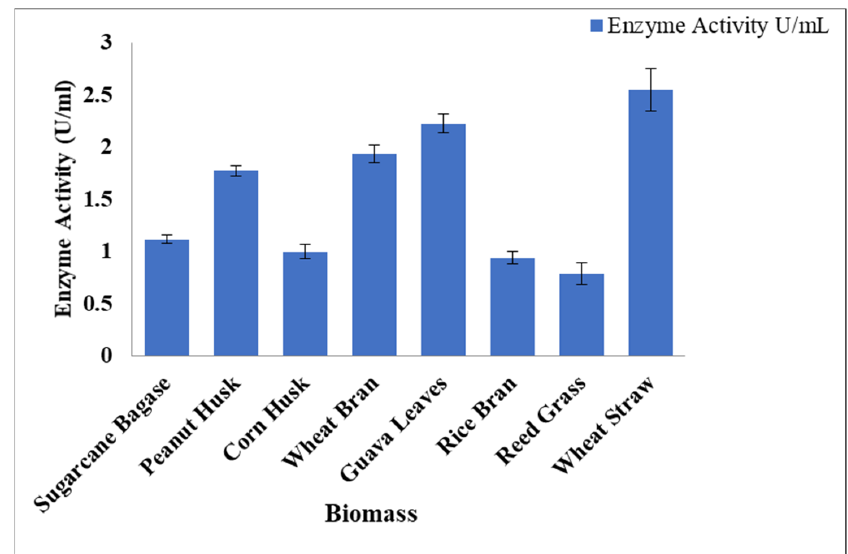
Figure 2. Screening of biomass for laccase production.